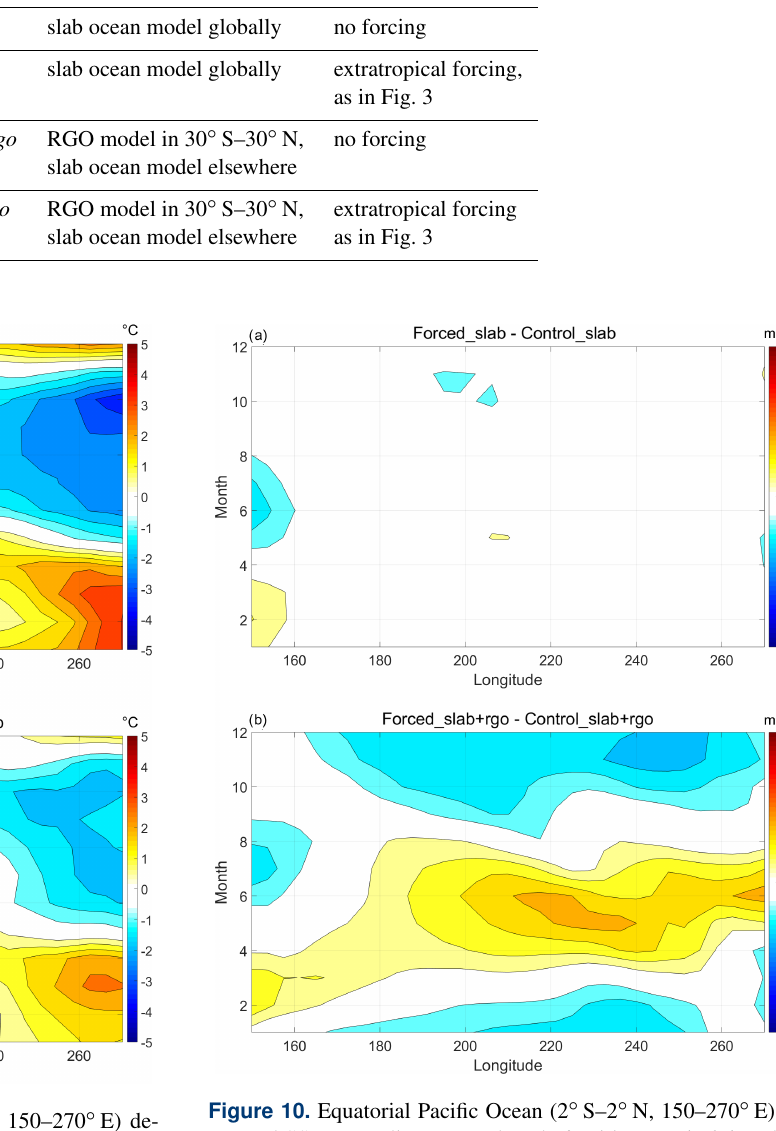
Figure 9. Equatorial Pacific Ocean (2 ◦ S–2 ◦ N, 150–270 ◦ E) de- meaned near-surface (950hPa) zonal wind anomalies seasonal cy- cle for (a) Forced_slab and (b) Forced_slab + rgo experiments. Contour interval: 0.5ms − 1 .